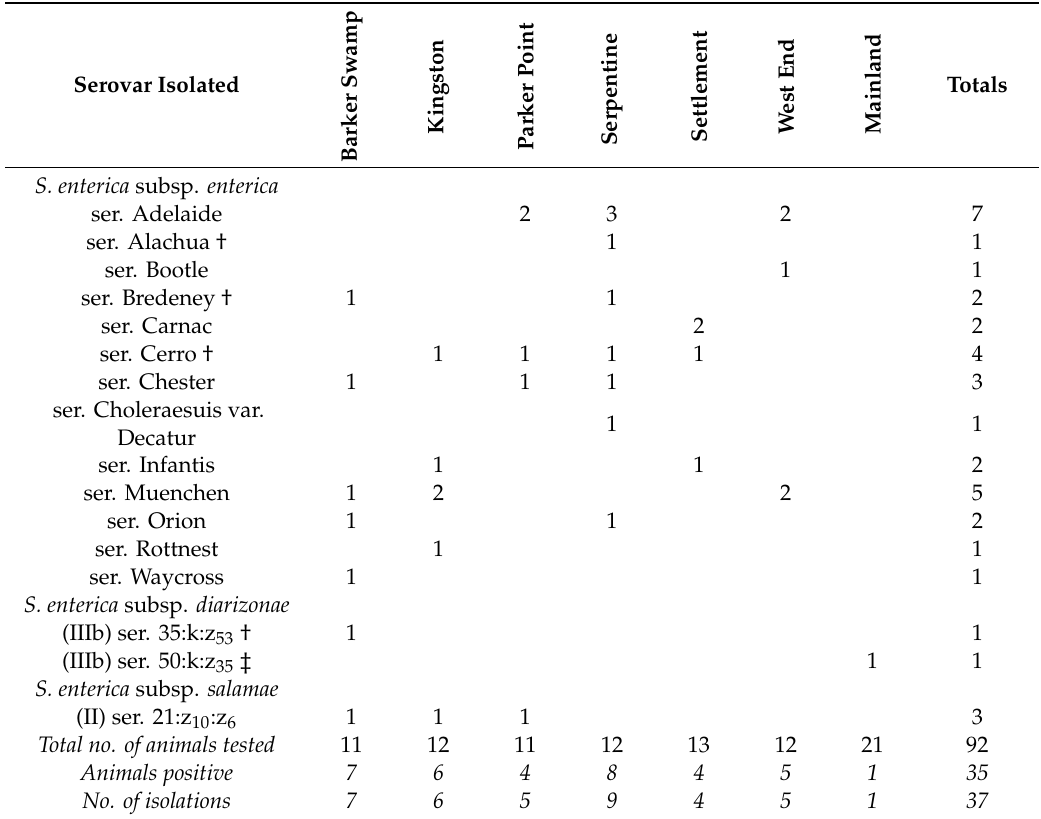
Table 1. Distribution and number of Salmonella isolations from quokkas on Rottnest Island and the mainland between June 2010 and December 2011.